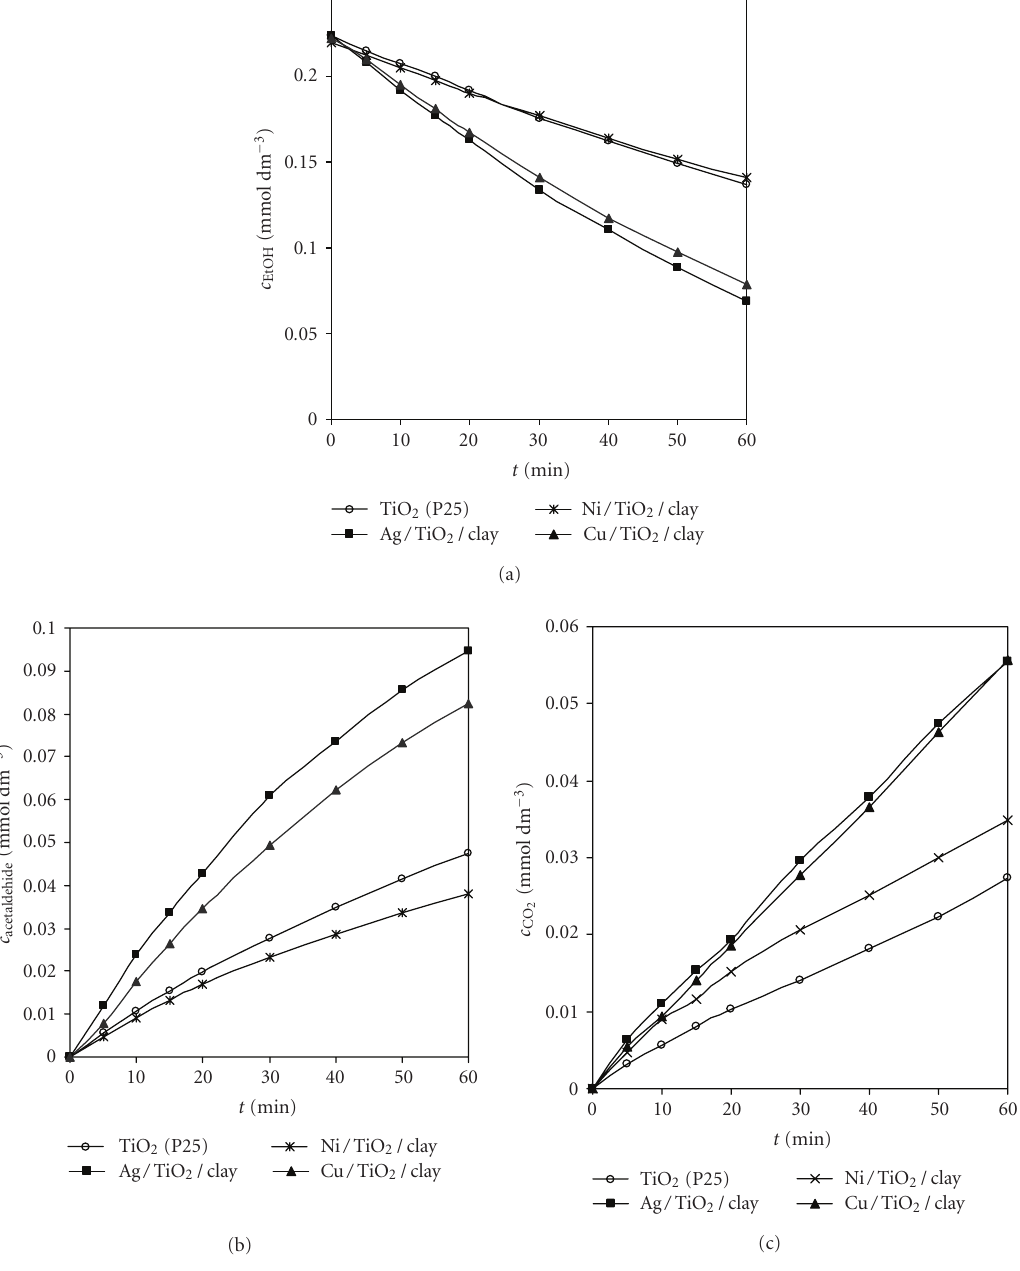
Figure 5: Ethanol concentration changes under (a) visible irradiation (light source 2), (b) kinetic curves of acetaldehyde, and (c) CO 2